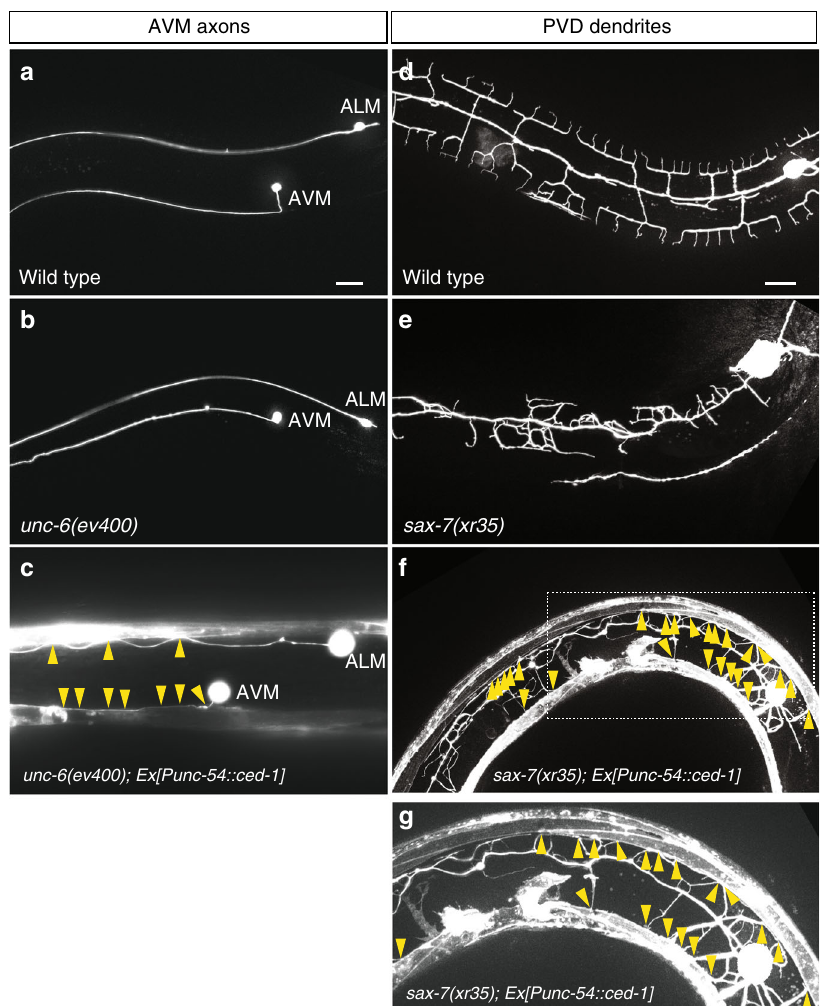
Fig. 4 CED-1-overexpressing muscle-type engul fi ng cells adhere AVM axons and PVD dendrites. Representative images showing wild-type AVM axons ( a ), unc-6 mutant AVM axons ( b ), wild-type PVD dendrites ( d ), and sax-7 mutant PVD dendrites ( e ). AVM axons ( c ) and PVD dendrites ( f ) without their respective guidance cues, unc-6 (netrin) and sax-7 (L1CAM), were redirected and adhered to muscles expressing CED-1. AVM neurons were labeled by zdIs5[Pmec-4::GFP] and PVD neurons were labeled by xrIs37[PF49H12.4::GFP] . The dashed box area in ( f ) was blown up and shown in ( g ). Arrowheads in ( c ), ( f ), and ( g ) indicate muscle contacts. Anterior is to the left, dorsal is up. Scale bar, 20 μ